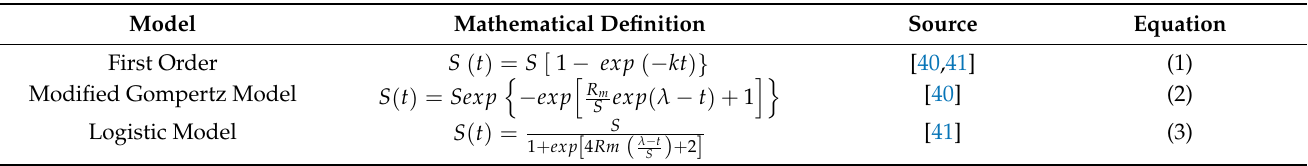
Table 5. Kinetic Model for anaerobic digestion